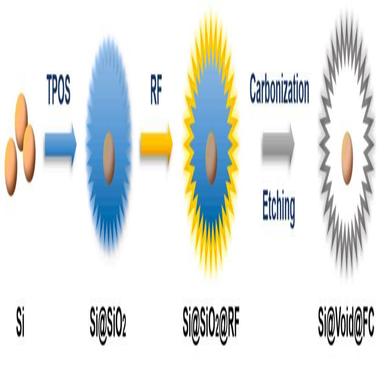
Synthesis of Si@Void@FC composite.